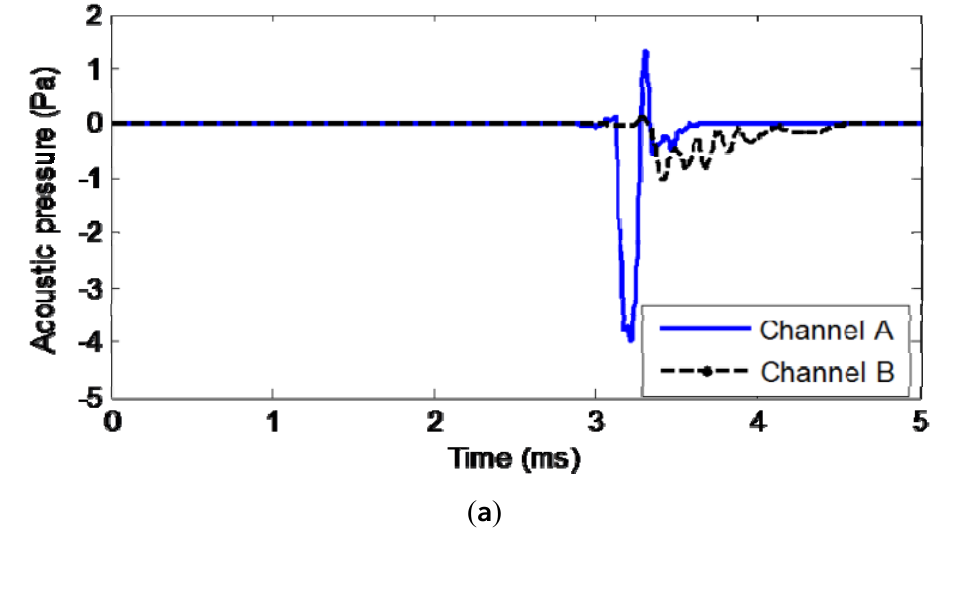
Figure 14. Pingree bridge deck test results. ( a ) Extracted radiating surface wave. ( b ) Joint crack. (c) Continuous scanning